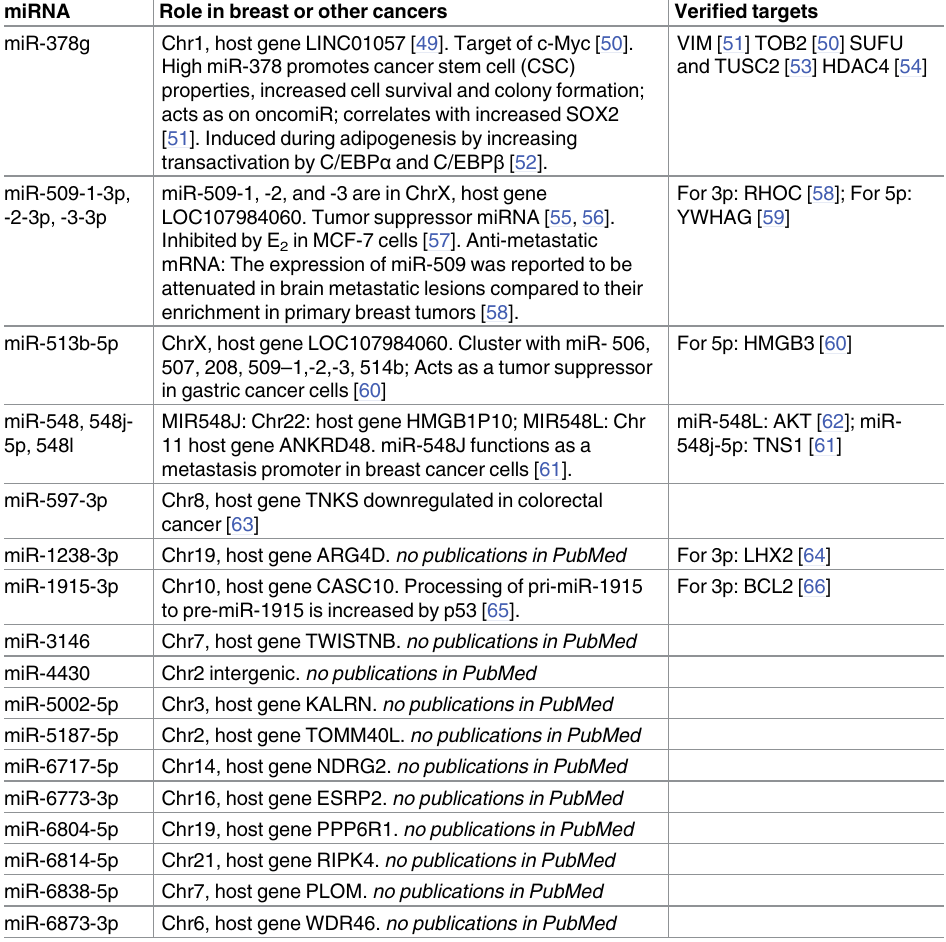
Table 3. miRNAsdownregulated by AnAc in MCF-7 cells. The genomiclocationof eachmiRNA was iden- tified in miRAD http://bmi.ana.med.uni-muenchen.de/miriad/ [34]. Verified targets are those experimentally validatedtargets of the indicatedmiRNA as demonstrated by 3’-UTR luciferasereporter assay. Since many publications do not includewhether the 5p or 3p arm of the miRNA was studied, if the sequenceof the miRNA was provided, it was searched in miRBase.org to identify which arm was used in the target gene 3’-UTR lucif- erase reporter assay. miRNA Role in breast or other cancers Verified targets